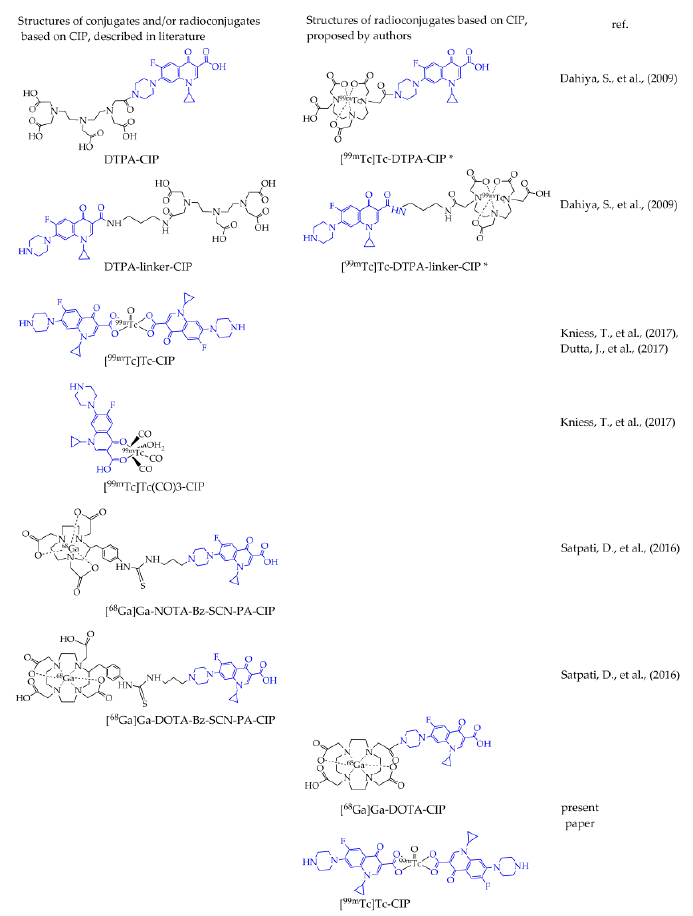
Figure 2. Structures of various CIP conjugates and radioconjugates described in the literature and this paper. The structure of the CIP molecule is marked with a blue color. * structures of [ 99m Tc]Tc-DTPA- CIP and [ 99m Tc]Tc-DTPA-linker-CIP radioconjugates were proposed by the authors of this paper, based on the structures of DTPA-CIP and DTPA-linker-CIP conjugates presented in the cited